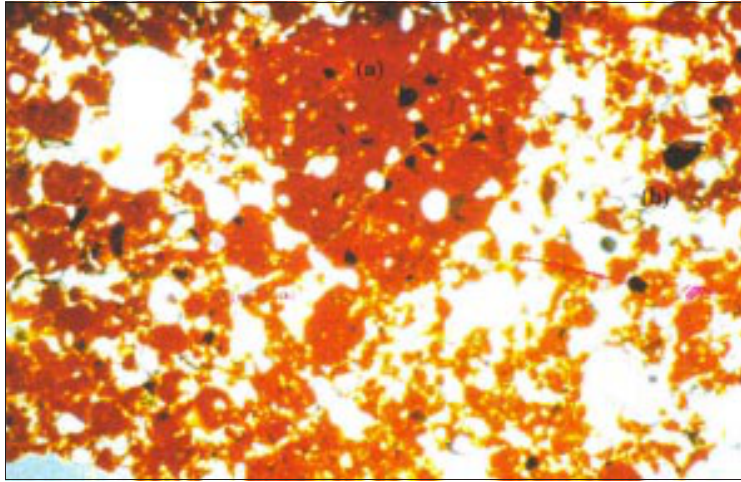
Figura 7. Fotomicrografia do horizonte Bw do Latossolo Vermelho-Escuro (LE), mostrando a ocorrência de (a) fragmentos de carvão constituindo o esqueleto triado de agregados de origem biológica e (b) fragmentos de carvão isolados no